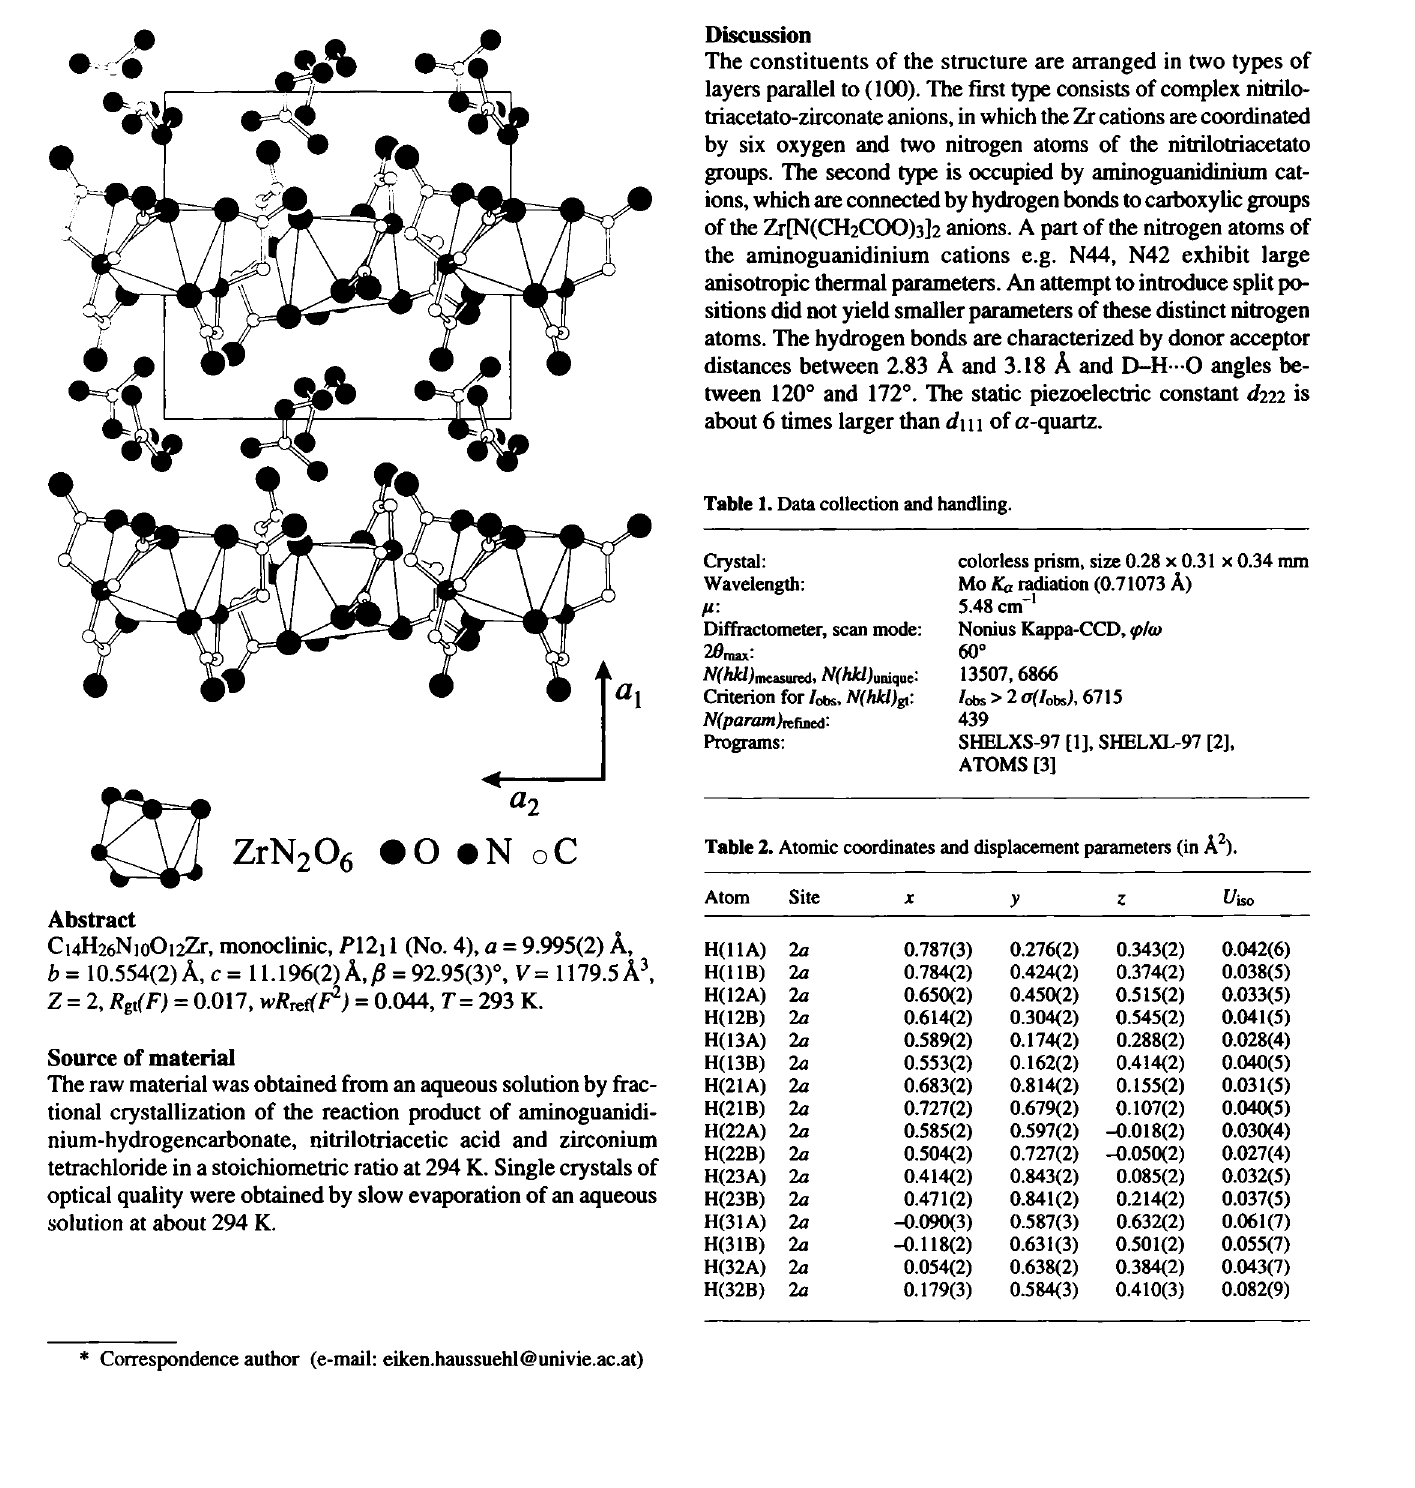
Table 1. Data collection and handling. Crystal: